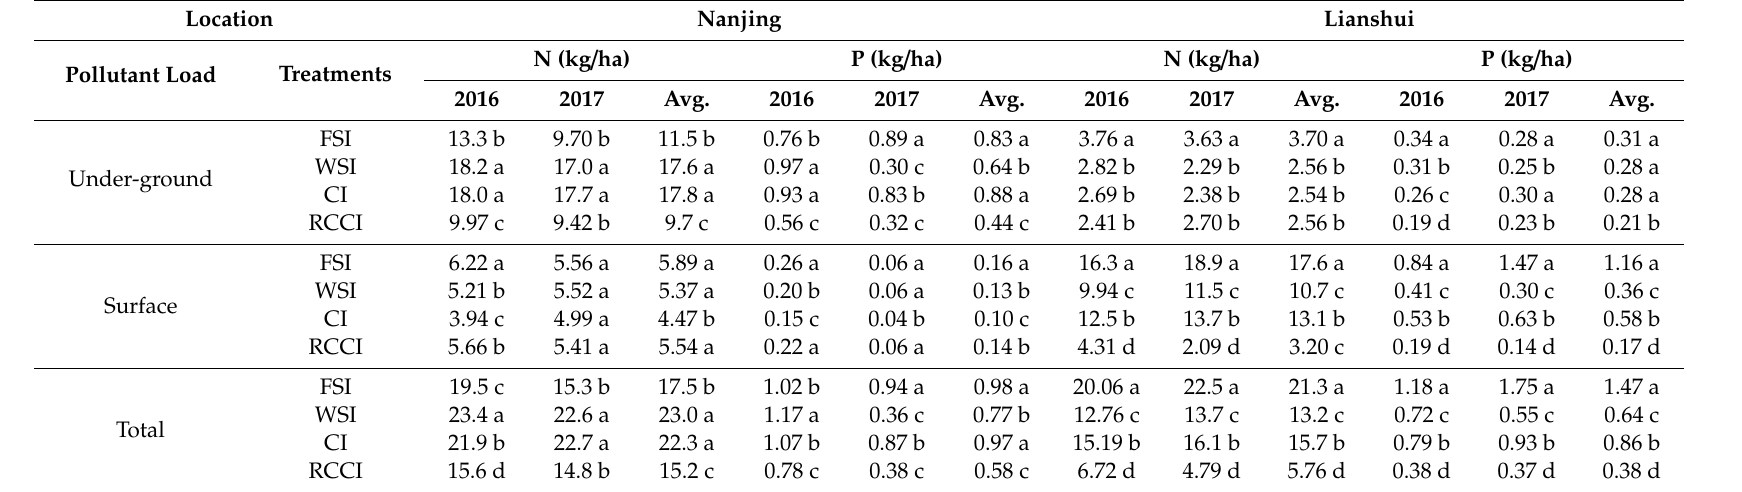
Table 3. E ff ect of di ff erent irrigation methods on pollutant